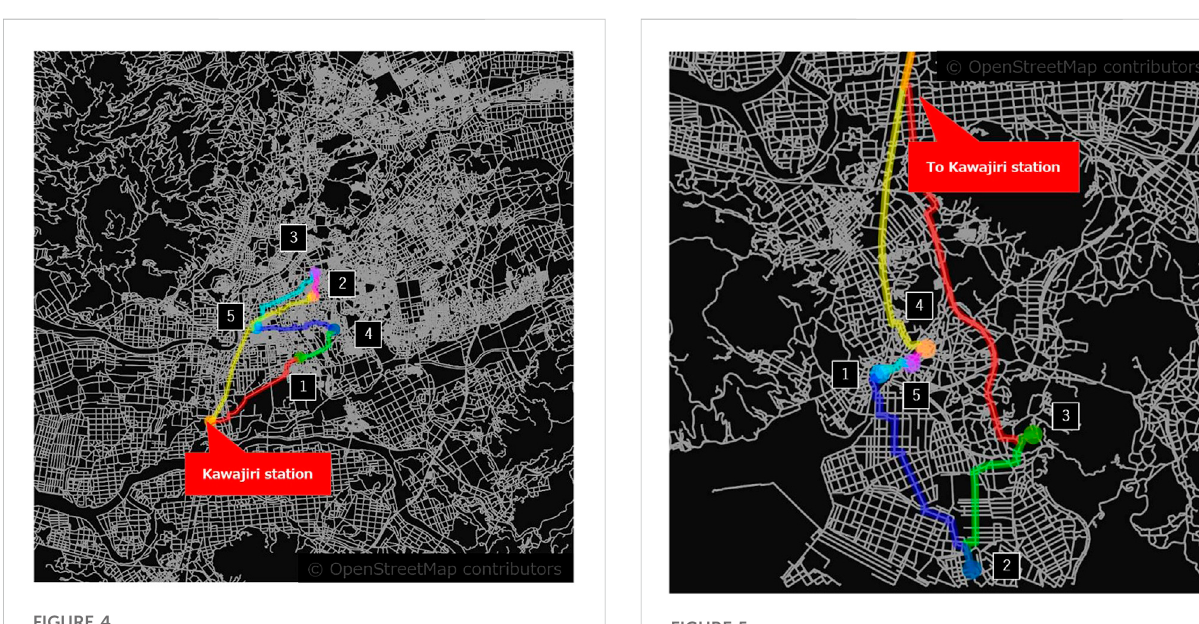
TABLE 4 Route optimization results for cluster No. 1 at instance No. 1 in the base case. Itinerary a Travel time (h) Arrival time (h) Arrival time zone Desired time zone Required time (h)